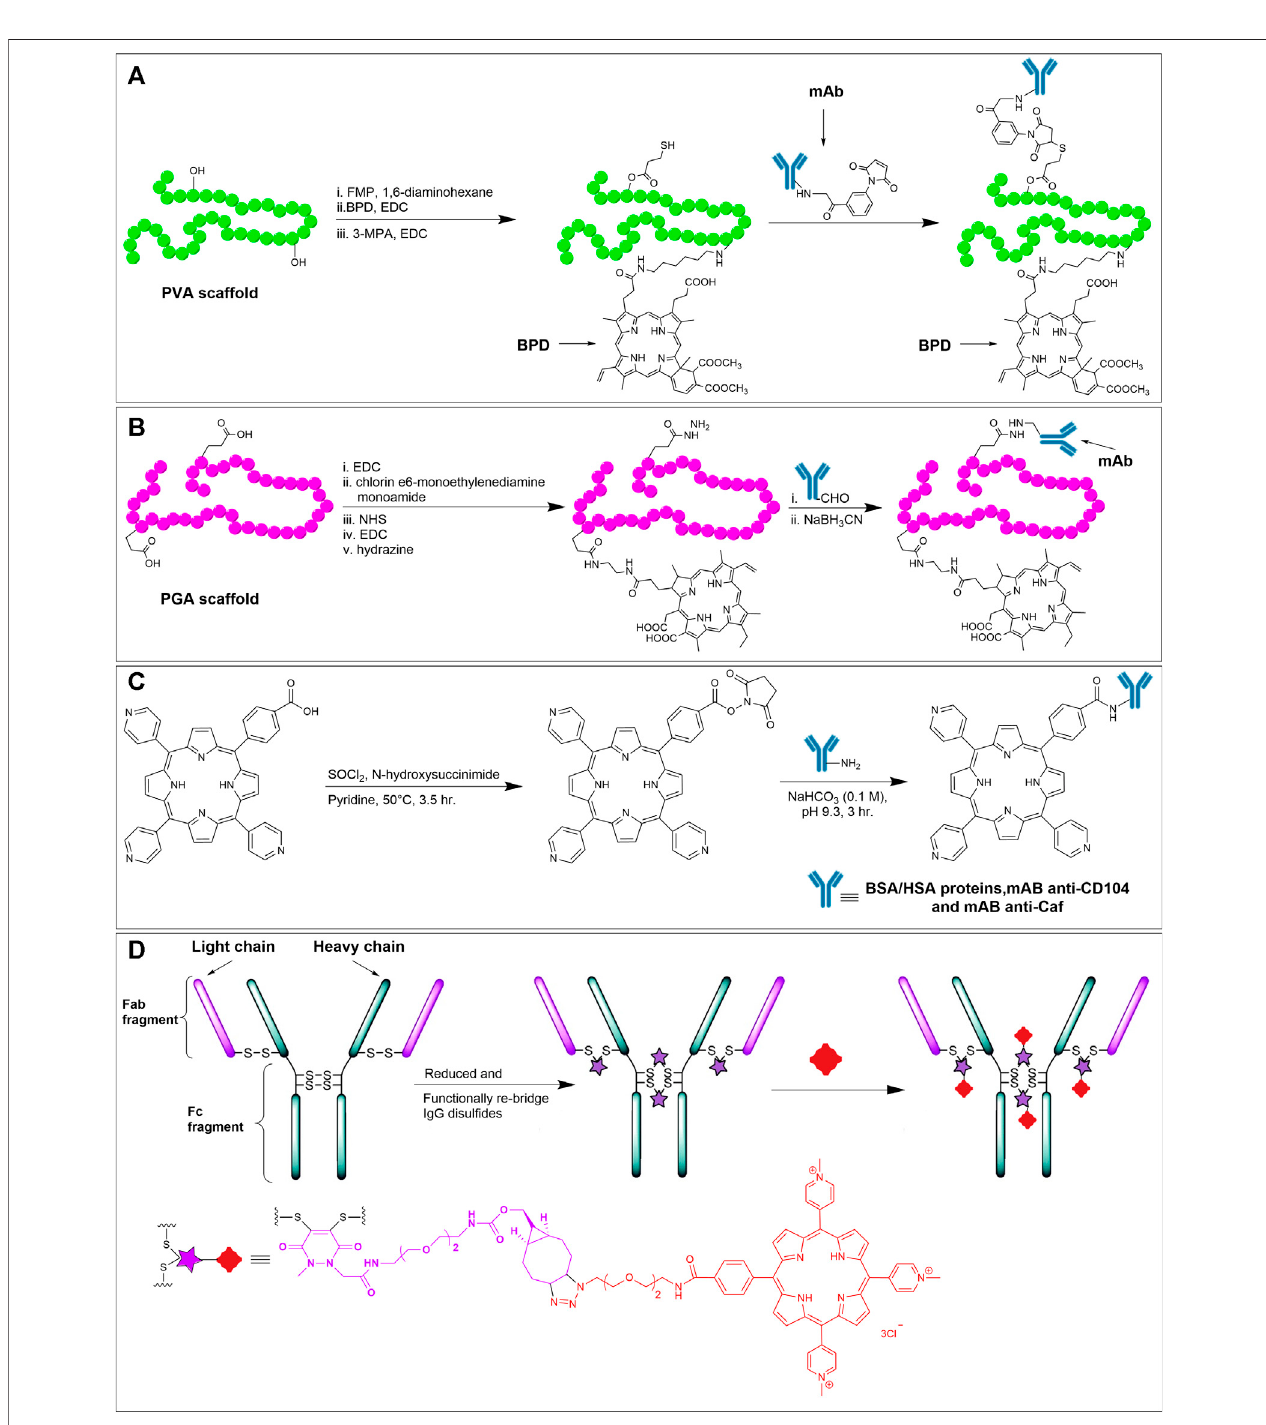
FIGURE 13 | (A) Synthetic scheme for mAb-BPD conjugate on a PVA scaffold (Hemming et al., 1993). (B) Synthesis of mAb (OC125)-chlorin e6 conjugate on a PGA scaffold (Goff et al., 1994). (C) Reaction scheme showing the NHS activated carboxylic acid on meso -tri (4-pyridyl)-mono- (4-carboxyphenyl) porphyrin, and subsequent conjugation with amines on albumins (Porphyrin-BSA and Porphyrin-HSA) or mAbs (anti-CD104 and anti-Caf) (Pereira et al., 2014). (D) Reduction of the disul fi des followed by functional re-bridging with the bifunctional linker generates the IgG with four strained cyclic alkynes, which react with azido TMPyP derivative to offer the antibody-porphyrin conjugate. Adapted with permission from (Maruani et al., 2015).